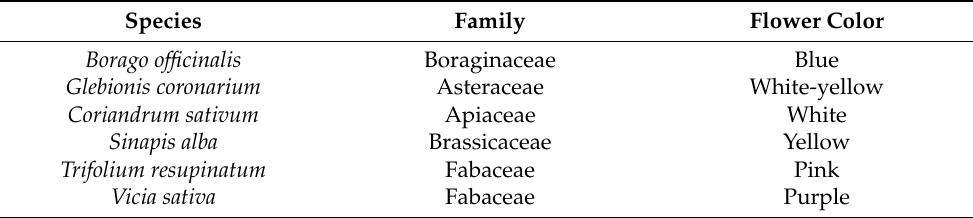
Table 1. Main characteristics of the species with the best implantation in the studied margins. Species Family Flower